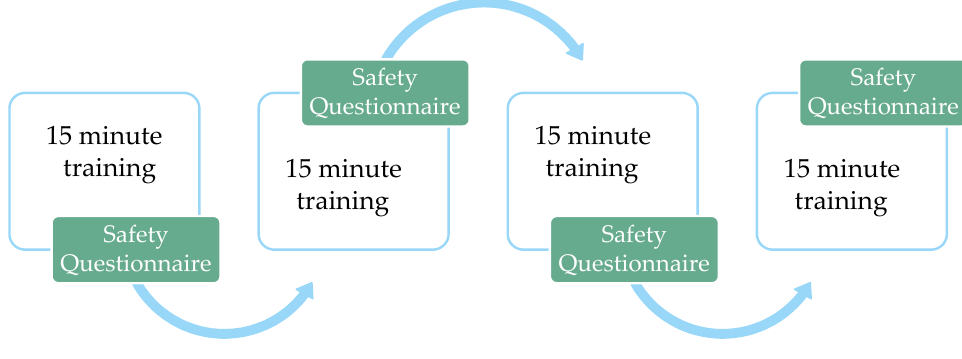
Figure 2. Timeline representation of Phase I.